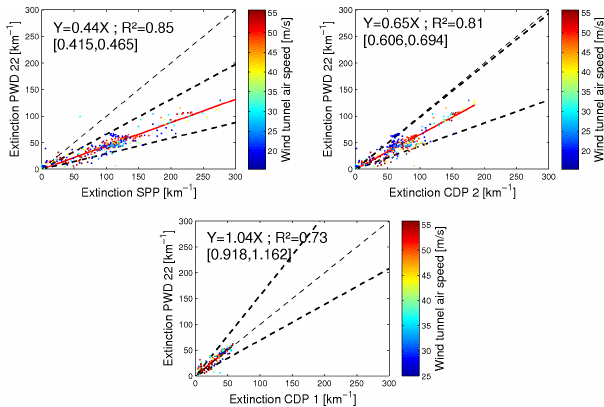
Figure 9. One minute averaged SPP, CDP 2 and CDP 1 extinctions, compared with the PWD extinction for the four wind tunnel exper- iments. The air speed applied in the wind tunnel is shown on the color bar. The bold dashed lines show the instrumental errors ap- plied to the fit. The confidence intervals with a confidence level of 99% are given in square brackets.